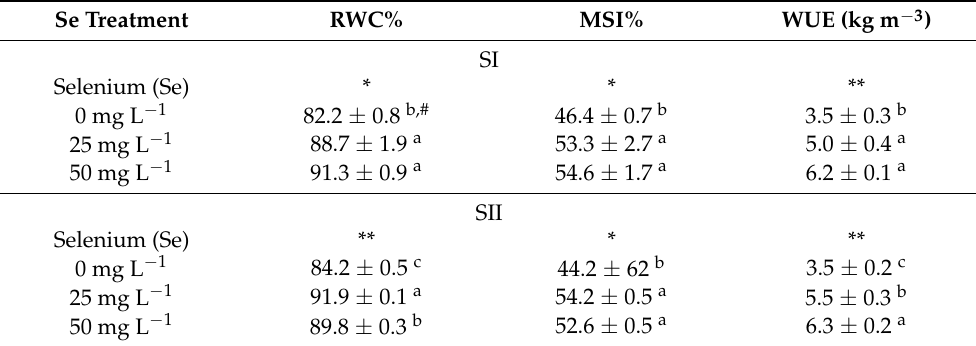
Table 4. Effects of foliar applications with Selenium (Se) on RWC%, MSI% and water use efficiency (WUE) of onion plants under saline soil (EC = 5.2 dS m − 1 ) condition in 2016/17 (SI) and 2017/18 (SII) seasons.